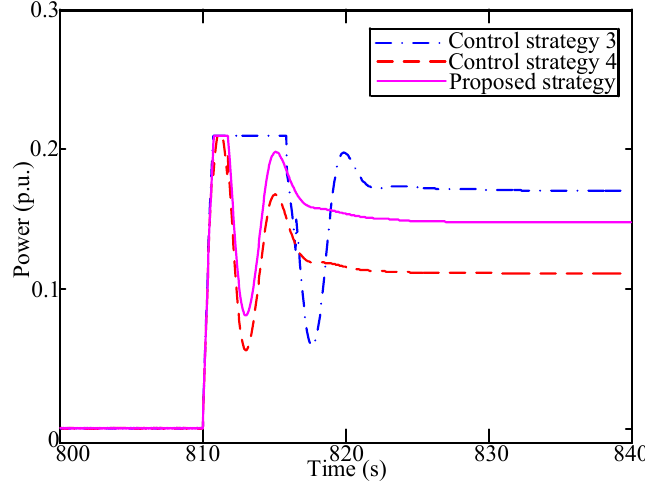
Figure 10. The power output of regulation generators under different allocation strategies.